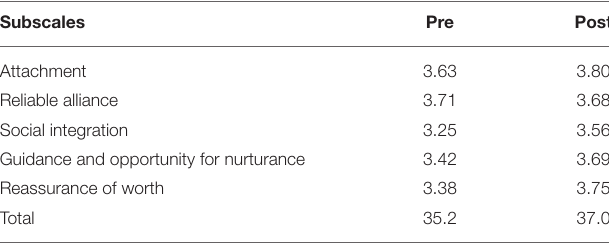
TABLE 3 | Social provision scale mean score (by dimension; pre and post-project